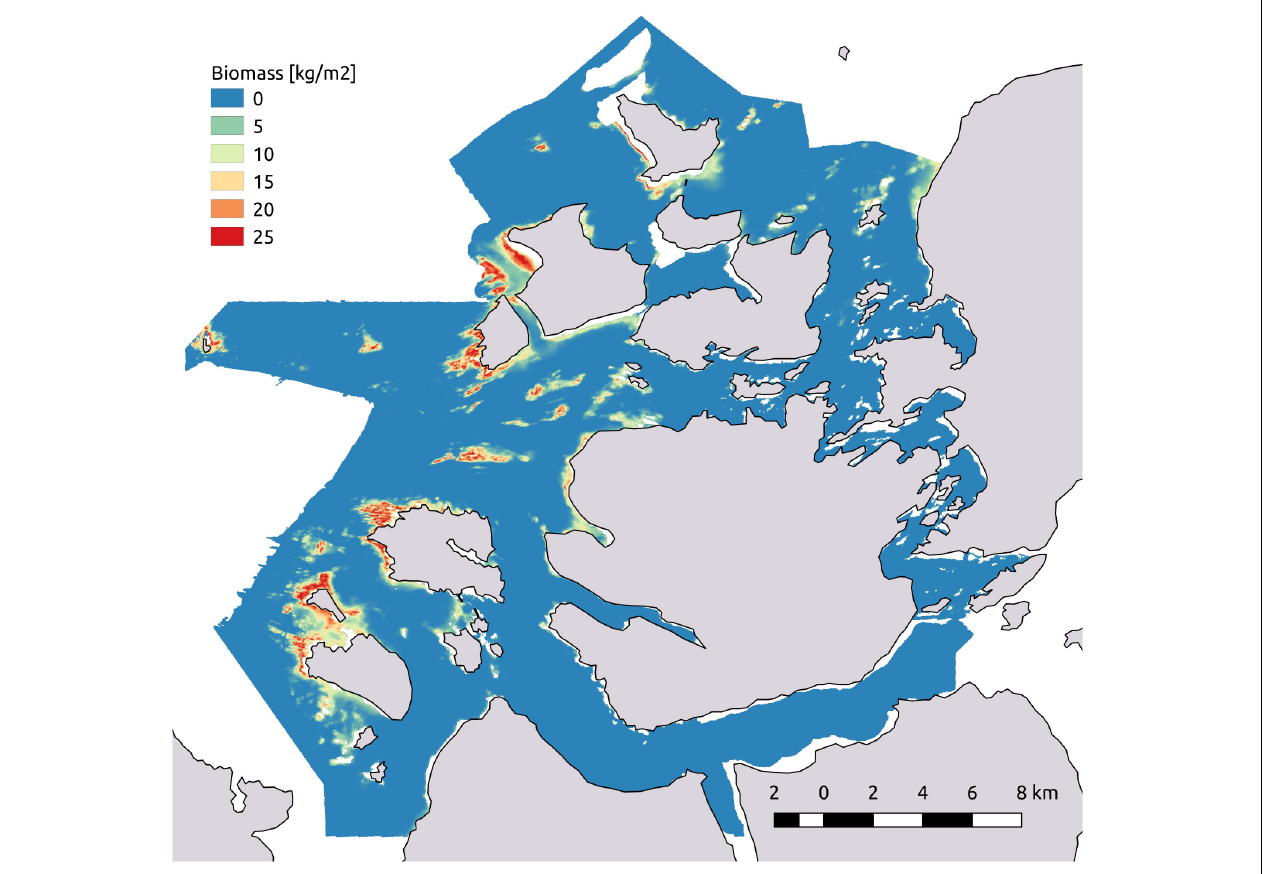
FIGURE 6 | Map of the spatial predictions of biomass of Laminaria hyperborea in kgm-2. Predictions are based on the model containing the predictors bottom wave exposure, depth, and proportion hard